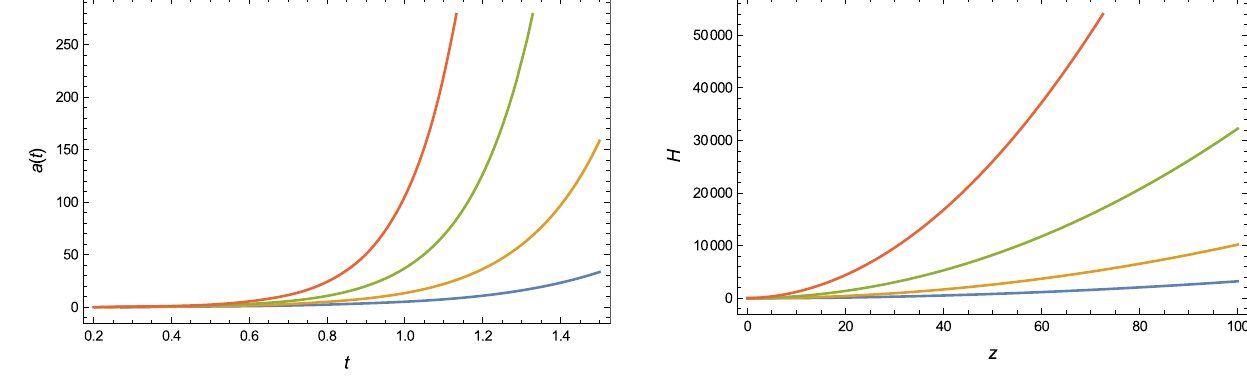
Fig. 10 Evolution of Hubble parameter with respect to redshift. The corresponding values of the mass term, M , are the same as in Fig. 8